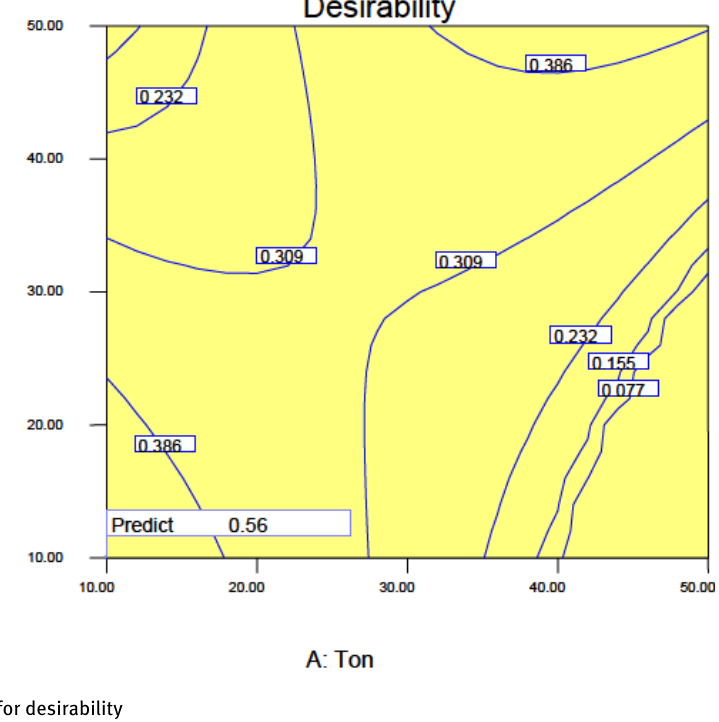
Figure 18: Graph between Ton and Toff for